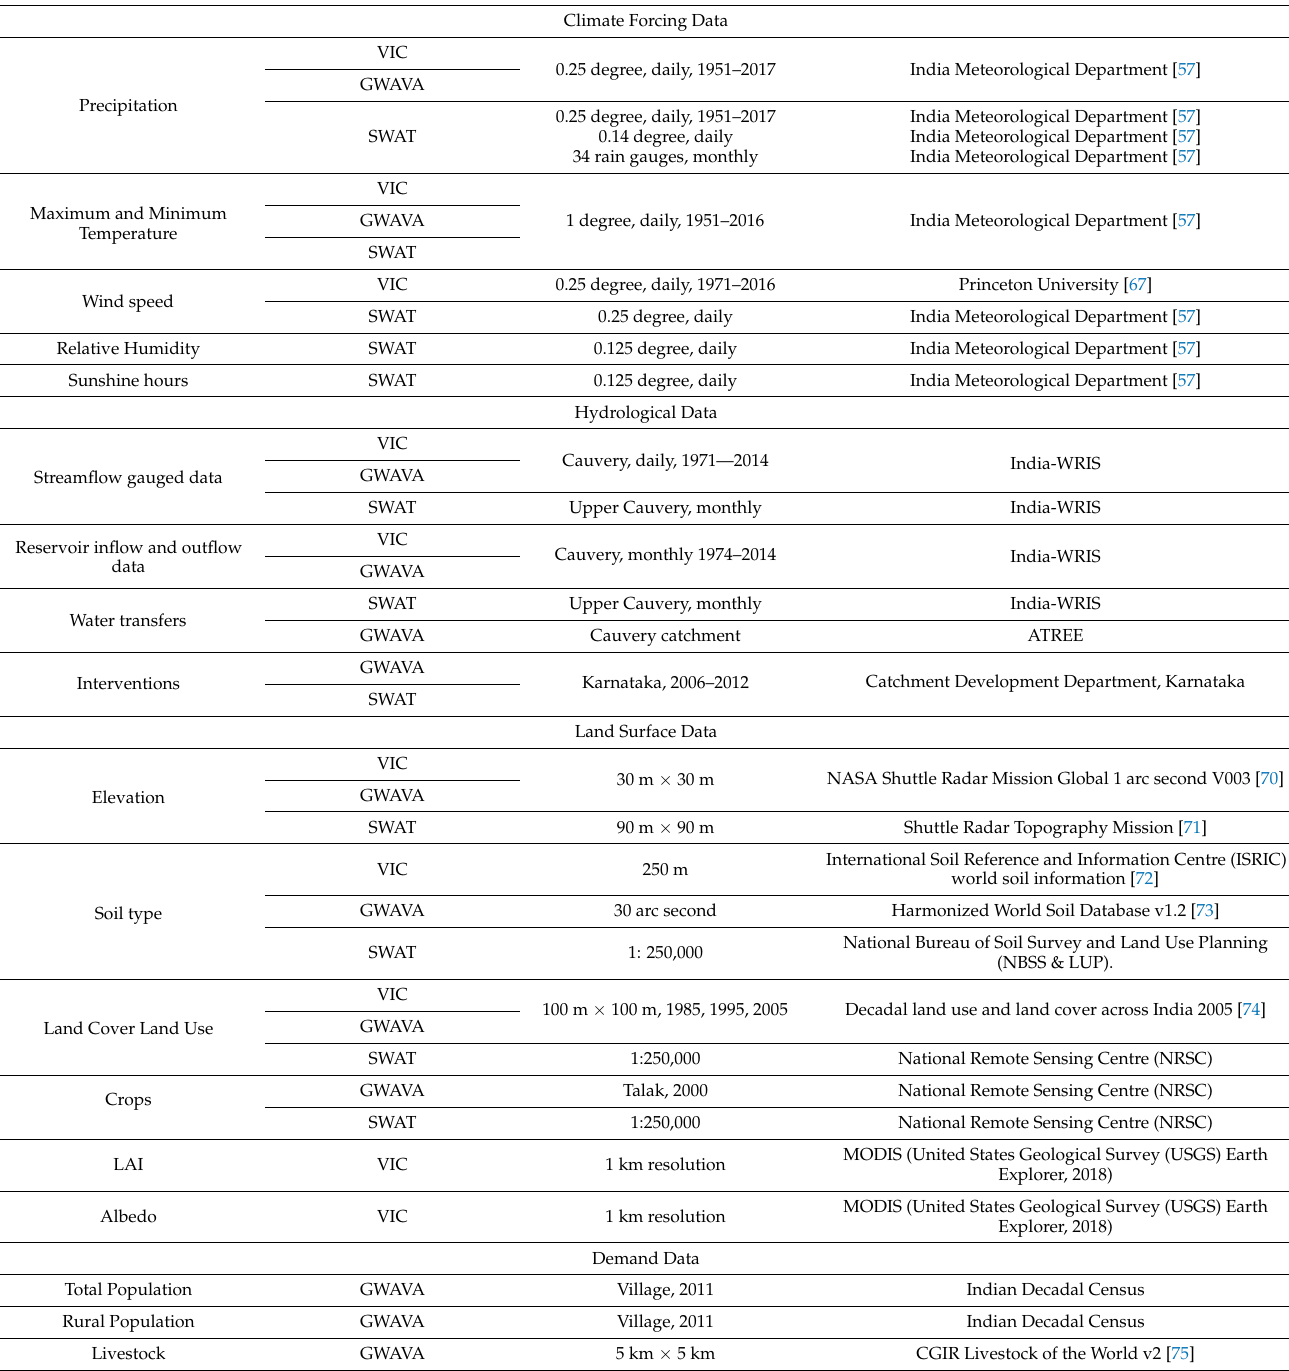
Table A2. Description and source of the model input